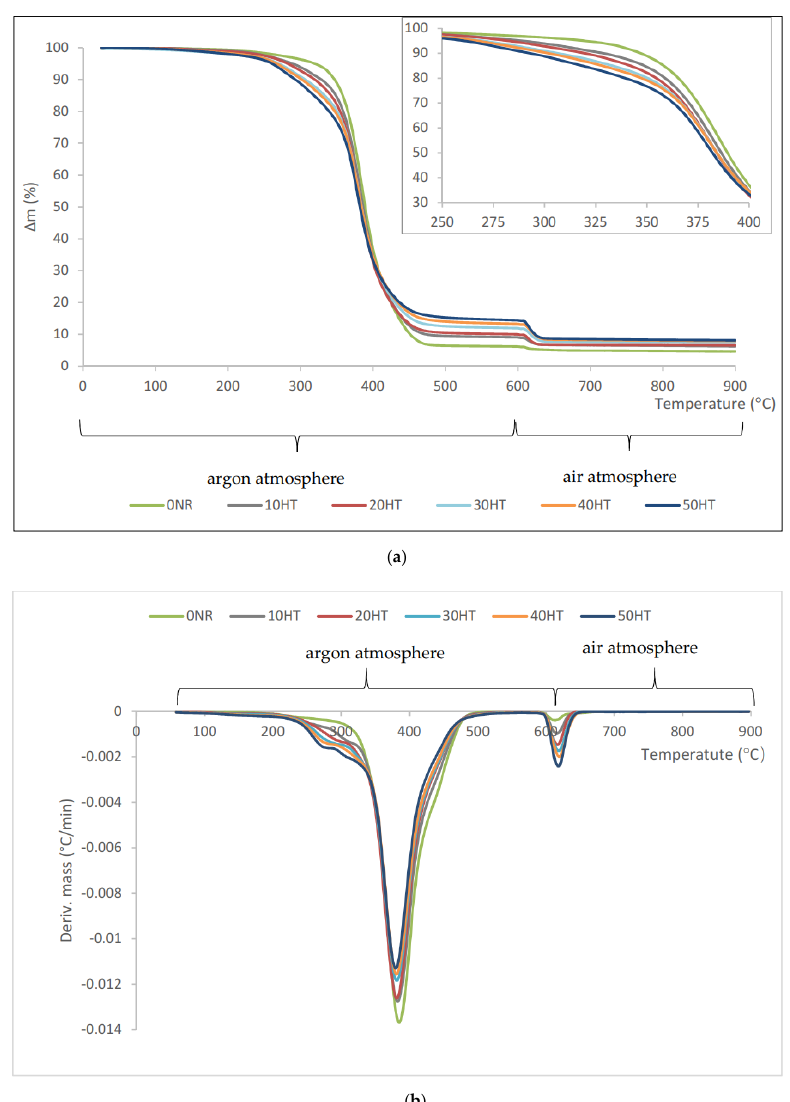
Figure 8. ( a ) TG and ( b ) DTG curves of natural rubber (NR) vulcanizates containing horsetail.